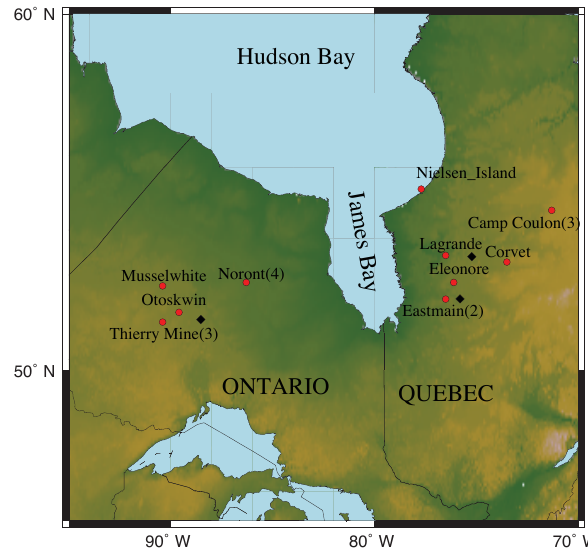
Figure 1. Map of Ontario and western Québec showing the location of sites (red dots). For sites with several boreholes (Camp Coulon, Eastmain, Thierry Mine, and Noront), the number of profiles avail- able is enclosed in parenthesis. Black diamonds show the locations of sites that were